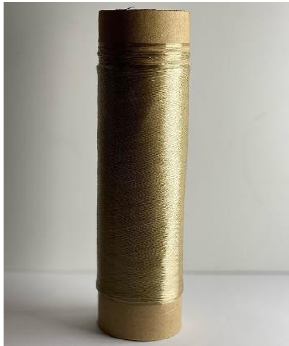
Figure 10. Photograph of a filament bobbin made from 7% solutions of flax noils cellulose in NMMO.